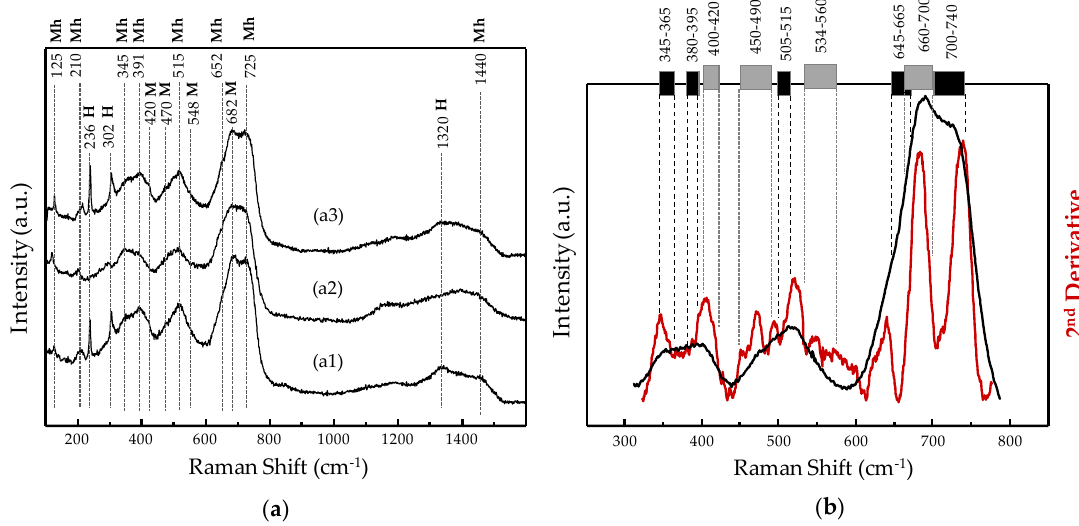
Figure 7. ( a ) Raman spectra of pristine Fe 3 O 4 -based substrate (a1), 3% Pd-Fe 3 O 4 (a2), and 3% AgPd-Fe 3 O 4 (a3) nanocomposite catalysts, collected at 0.6 mW. ( b ) High-resolution Raman spectrum and its